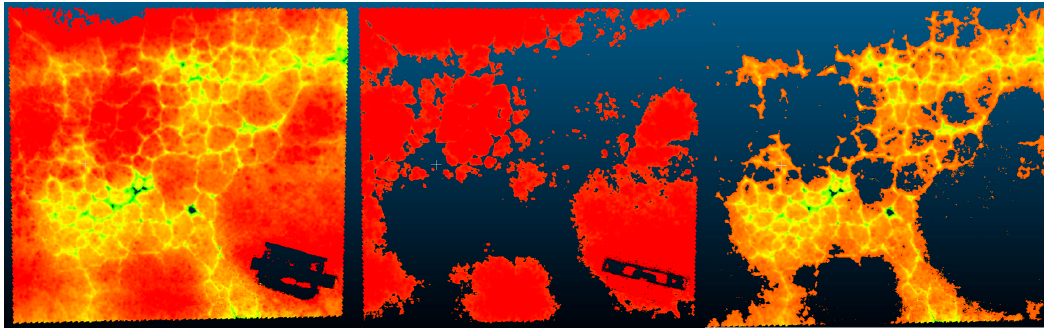
Figure 27. Segmentation of pavement section 3 with RANSAC.